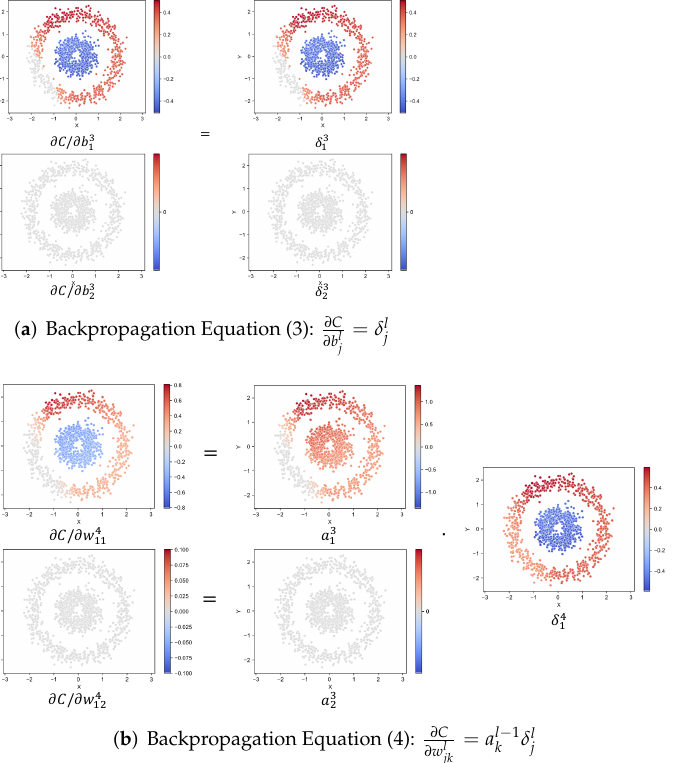
) are 0, 1 cannot propagate to δ 3 . In 1 1 propagating to δ 3 . 2 1